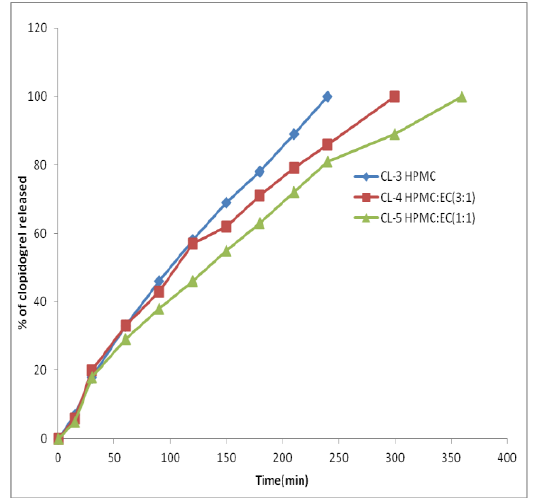
Figure 3: The effect of EC concentration on the of clopidogrel in 0.1 NHCl and 37  C